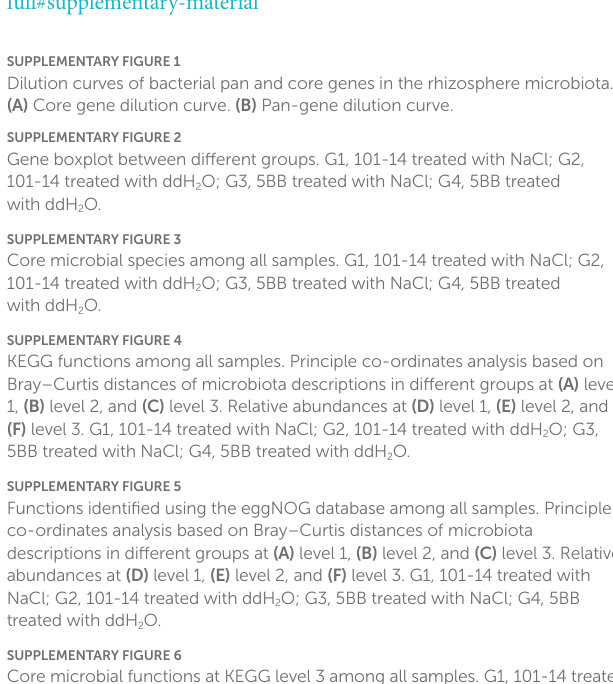
SUPPLEMENTARY FIGURE 1 Dilution curves of bacterial pan and core genes in the rhizosphere microbiota. (A) Core gene dilution curve. (B) Pan-gene dilution curve. SUPPLEMENTARY FIGURE 2 Gene boxplot between different groups. G1, 101-14 treated with NaCl; G2, 101-14 treated with ddH 2 O; G3, 5BB treated with NaCl; G4, 5BB treated with ddH 2 O. SUPPLEMENTARY FIGURE 3 Core microbial species among all samples. G1, 101-14 treated with NaCl; G2, 101-14 treated with ddH 2 O; G3, 5BB treated with NaCl; G4, 5BB treated with ddH 2 O. SUPPLEMENTARY FIGURE 4 KEGG functions among all samples. Principle co-ordinates analysis based on Bray–Curtis distances of microbiota descriptions in different groups at (A) level 1, (B) level 2, and (C) level 3. Relative abundances at (D) level 1, (E) level 2, and (F) level 3. G1, 101-14 treated with NaCl; G2, 101-14 treated with ddH 2 O; G3, 5BB treated with NaCl; G4, 5BB treated with ddH 2 O. SUPPLEMENTARY FIGURE 5 Functions identified using the eggNOG database among all samples. Principle co-ordinates analysis based on Bray–Curtis distances of microbiota descriptions in different groups at (A) level 1, (B) level 2, and (C) level 3. Relative abundances at (D) level 1, (E) level 2, and (F) level 3. G1, 101-14 treated with NaCl; G2, 101-14 treated with ddH 2 O; G3, 5BB treated with NaCl; G4, 5BB treated with ddH 2 O. SUPPLEMENTARY FIGURE 6 Core microbial functions at KEGG level 3 among all samples. G1, 101-14